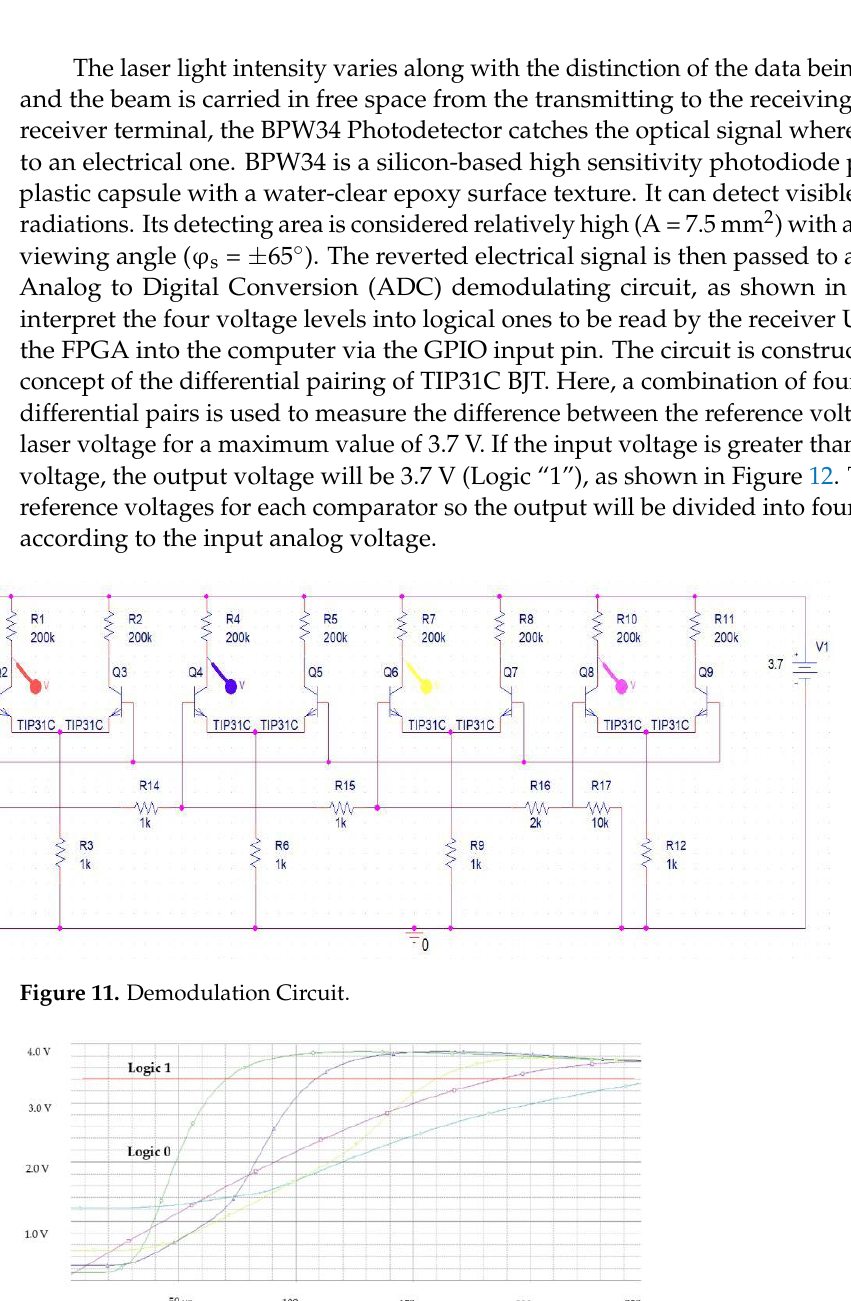
Figure 10. ModelSim Simulation Waveform.